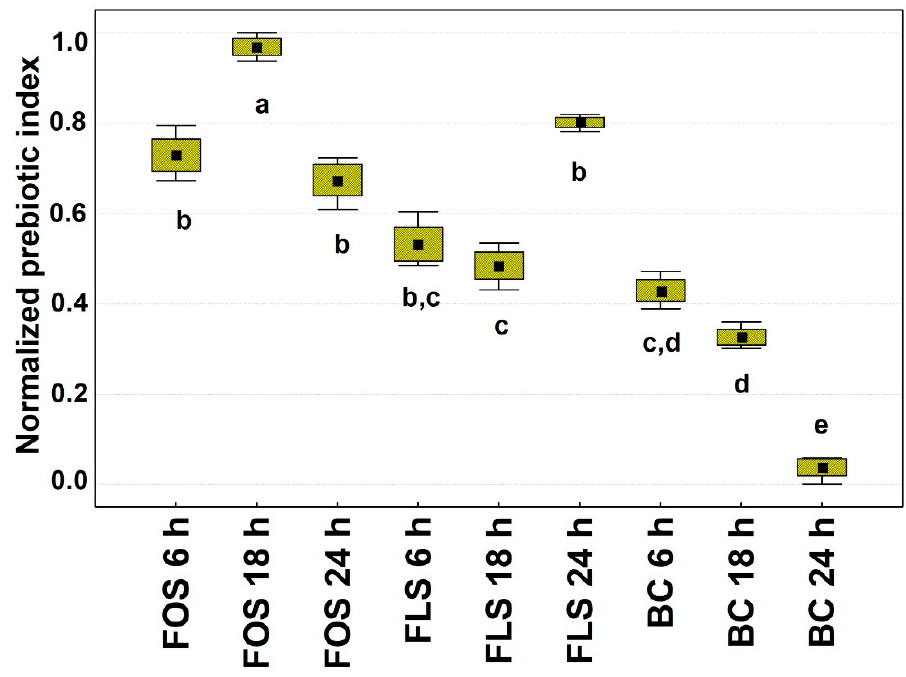
Figure 6. qPCR Prebiotic Index (qPI). FOS = Fructooligosaccharides; FLS = tested fiber; BC = Blank control. a,b,c,d,e Different letters indicate statistical significance by Tukey’s HSD test ( p < 0.05). Black squares = mean; Boxes = mean ± S.D.; Whiskers = min and max.